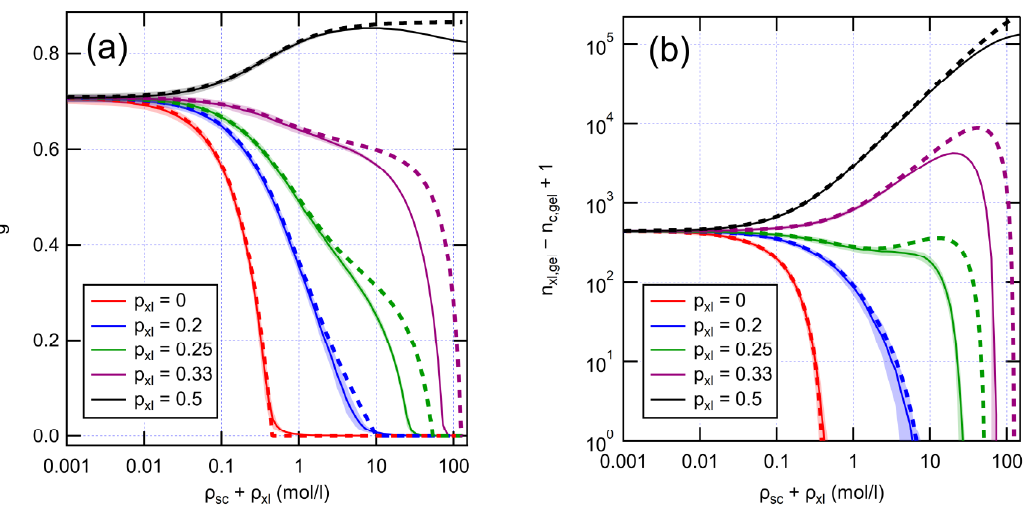
Figure 4. Evolution of ( a ) gel fraction and ( b ) cycle rank as a function of aging reactions with different values for p xl . Initial XLPE has M w,chains = 5600 g/mol and the total number of monomers is 10 6 . Solid and dashed lines are results from numerical and analytical models, respectively. Numerical results are averaged over 100 runs. Shading represents standard